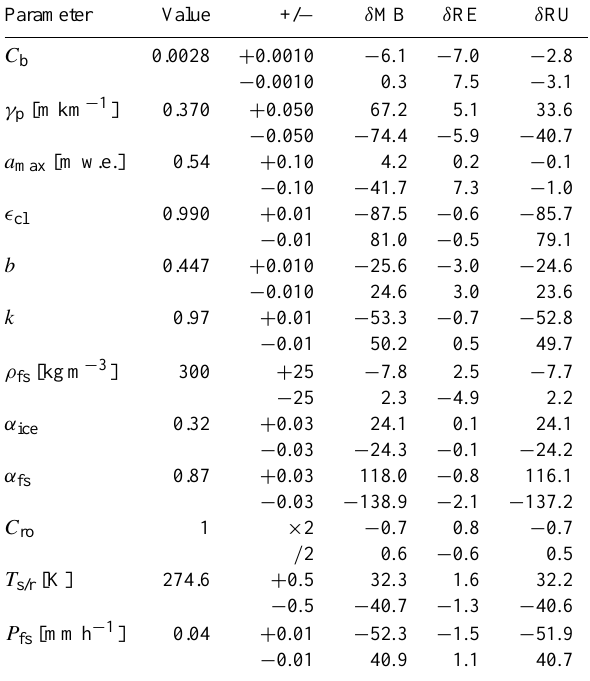
Table 1. Overview of the mass balance sensitivity ( δ MB), refreez- ing sensitivity ( δ RE) and runoff sensitivity ( δ RU) to perturbations of a selection of model parameters. Sensitivities are given in mm w.e.a − 1 .